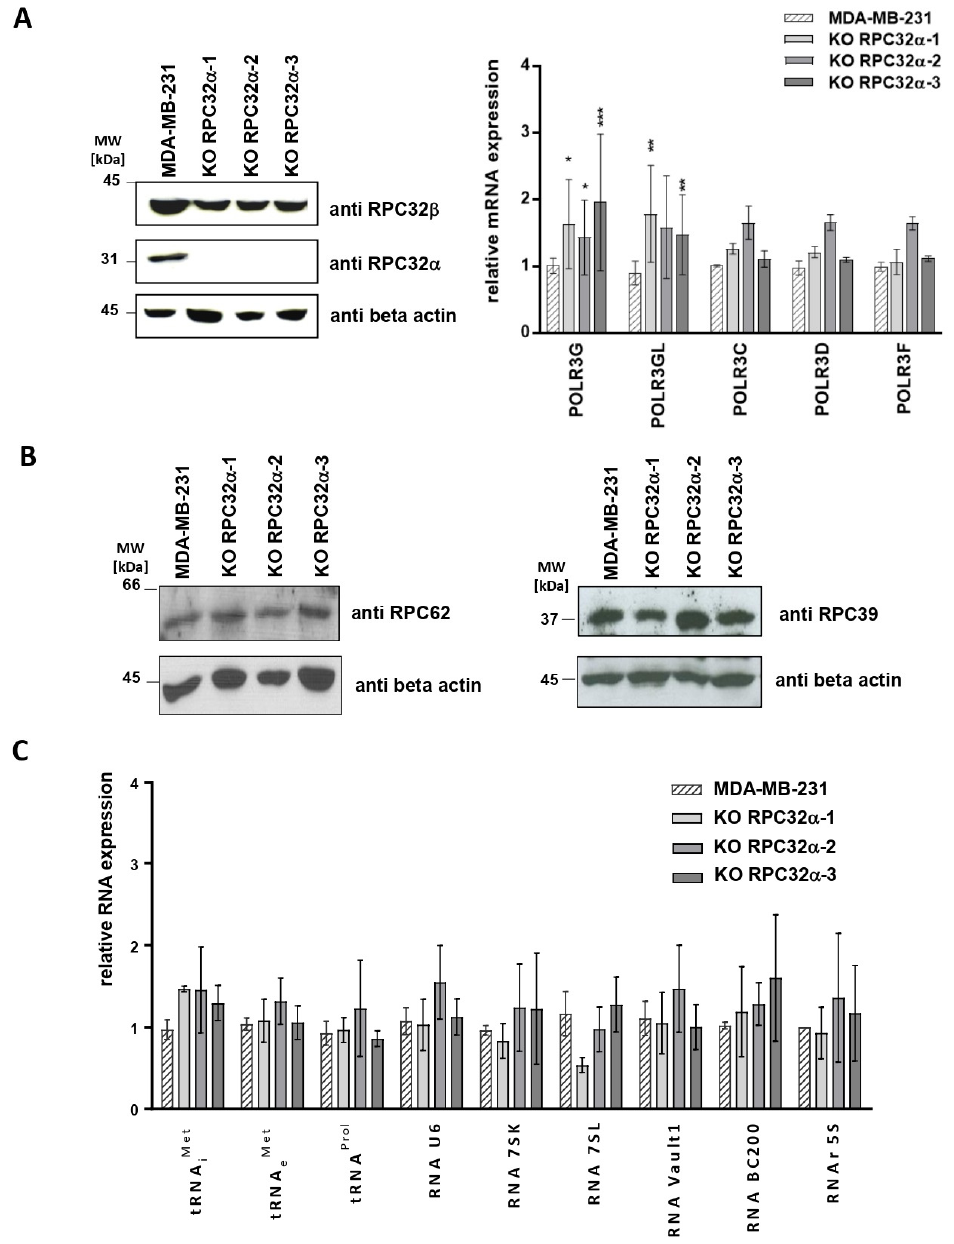
Figure 4. Molecular characterization of POLR3G KO (3GKO) clones. ( A ) Analysis of POLR3G KO (3GKO) clones by Western blot (to the left) with anti-RPC32 α , -RPC32 β and -beta-actin antibodies (Materials and Methods). Detected proteins are depicted to the right, the MDA-MB231 and 3GKO cell lines that were analyzed are appropriately indicated above the ECL images. Determination of Pol III subunit mRNA levels (to the right) in MDA-MB231 and 3GKO cell lines derived therefrom by RT-qPCR (Materials and Methods). Analyzed genes are indicated below the graphs. Relative mean expression levels of three independent experiments ± SEM (* p < 0.05, ** p < 0.01, and *** p < 0.001) are shown. ( B ) Western blot analyses of RPC62 (left panel) end RPC39 expression (right panel) in MDA-MB231 and 3GKO cells. Analyzed cell lines are appropriately depicted above the ECL image. ( C ) RT-qPCR analyses of the expression of RNA polymerase III-transcribed RNAs in MDA-MB231 cells and the three 3GKO clones. Relative mean expression levels of three independent experiments ± SEM (* p < 0.1, ** p < 0.01 and *** p < 0.001 compared with MDA-MB-231) are shown. The uncropped images of Western Blots shown in Figure 4A,B can be found in Figure